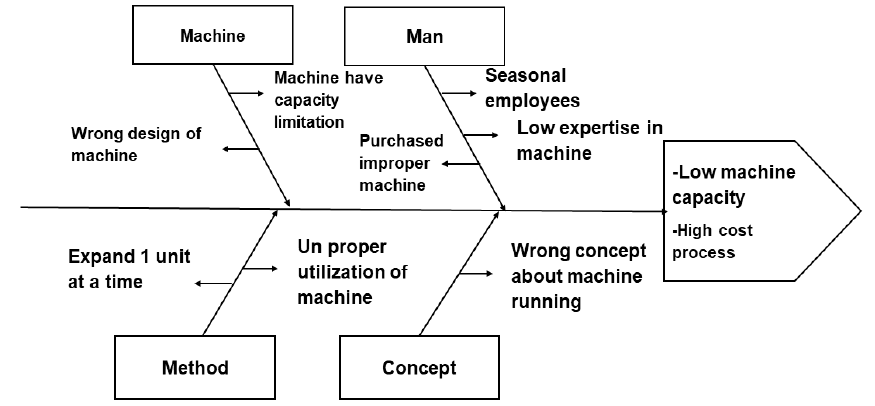
Figure 6. Fishbone diagram for expanding machine (Condenser manufacturing).